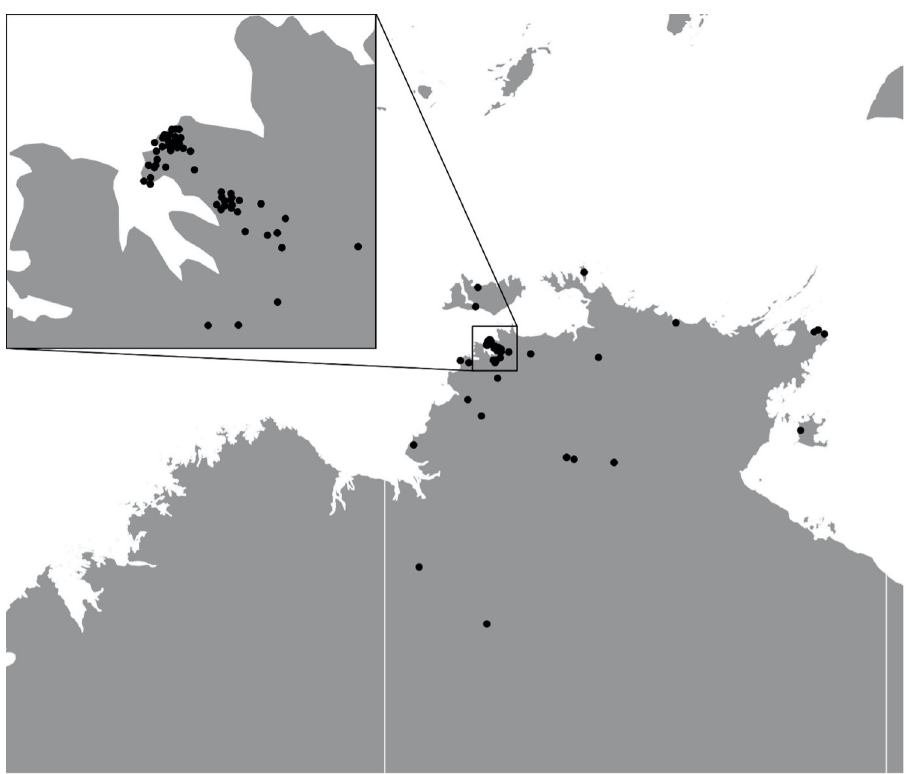
Fig 1. Geographic distribution of residential addresses of patients presenting with Pasteurella spp.